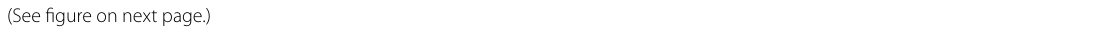
figure on next Fig. 8 Examples of Thellier–Coe experiments shown in Arai plots with pTRM checks as triangles, and accepted steps as dots. The insets show orthogonal vector component projections in sample coordinates (vertical plane: open, blue symbols; horizontal plane: solid, red symbols, green line: mean direction associated with the chosen temperature interval). Further information can be found in Additional file 3: Table S3 and Additional file 8: Fig.